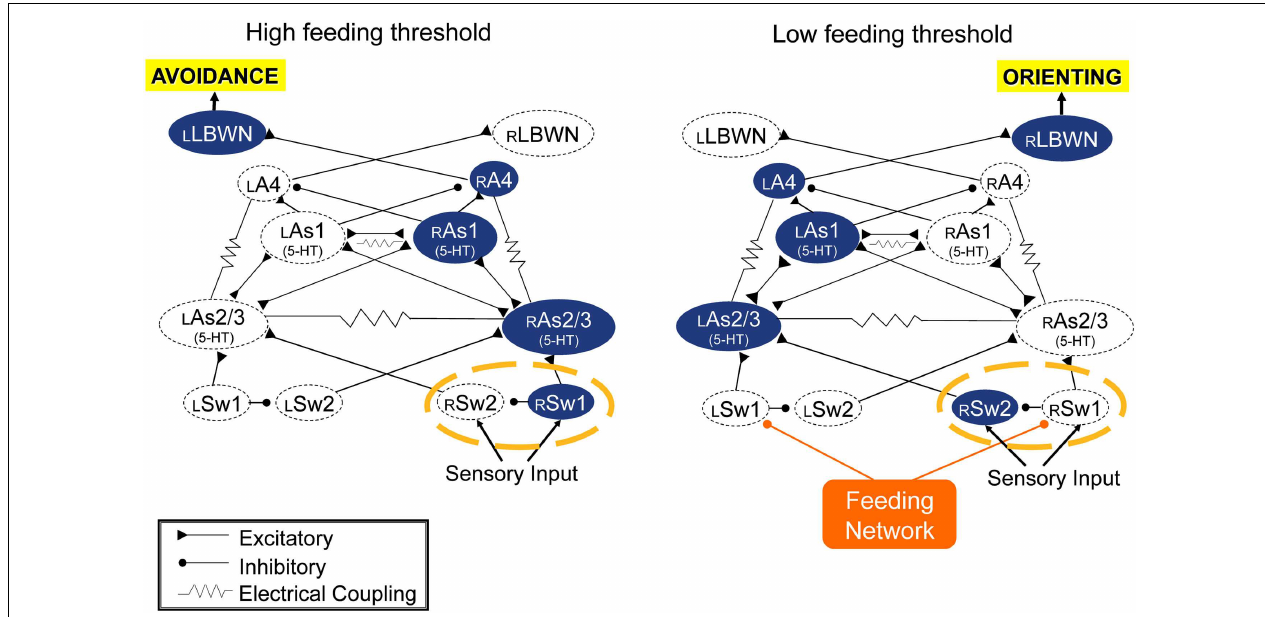
FIGURE 4 | Simulation suggests that the turn network is default organized for avoidance responses to unilateral sensory inputs (left), and that inputs from the feeding network could reverse responses to